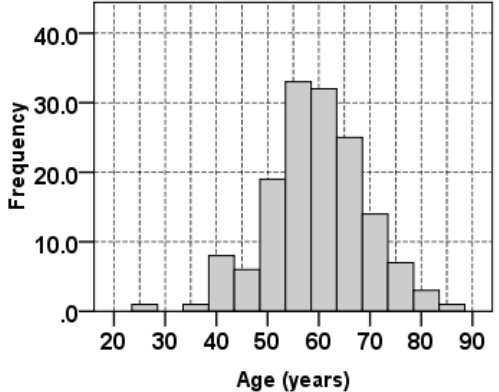
Figure 01.Age distribution of the study